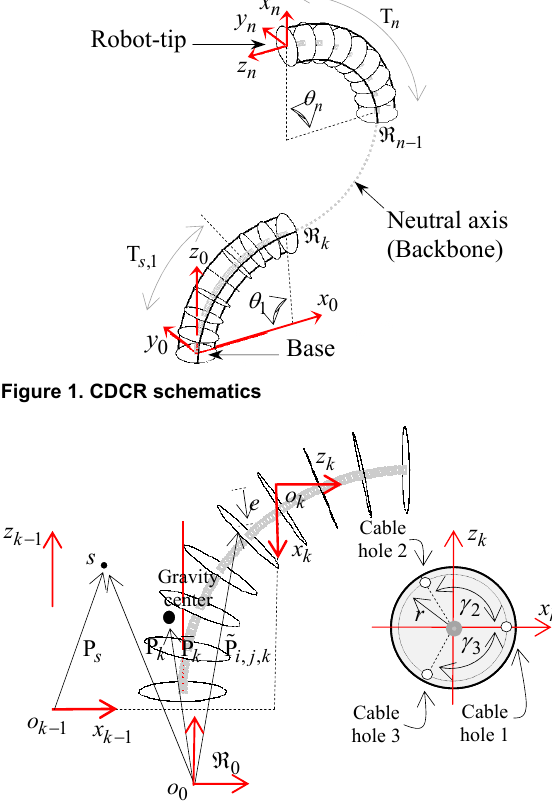
Figure 2. Single bending-section